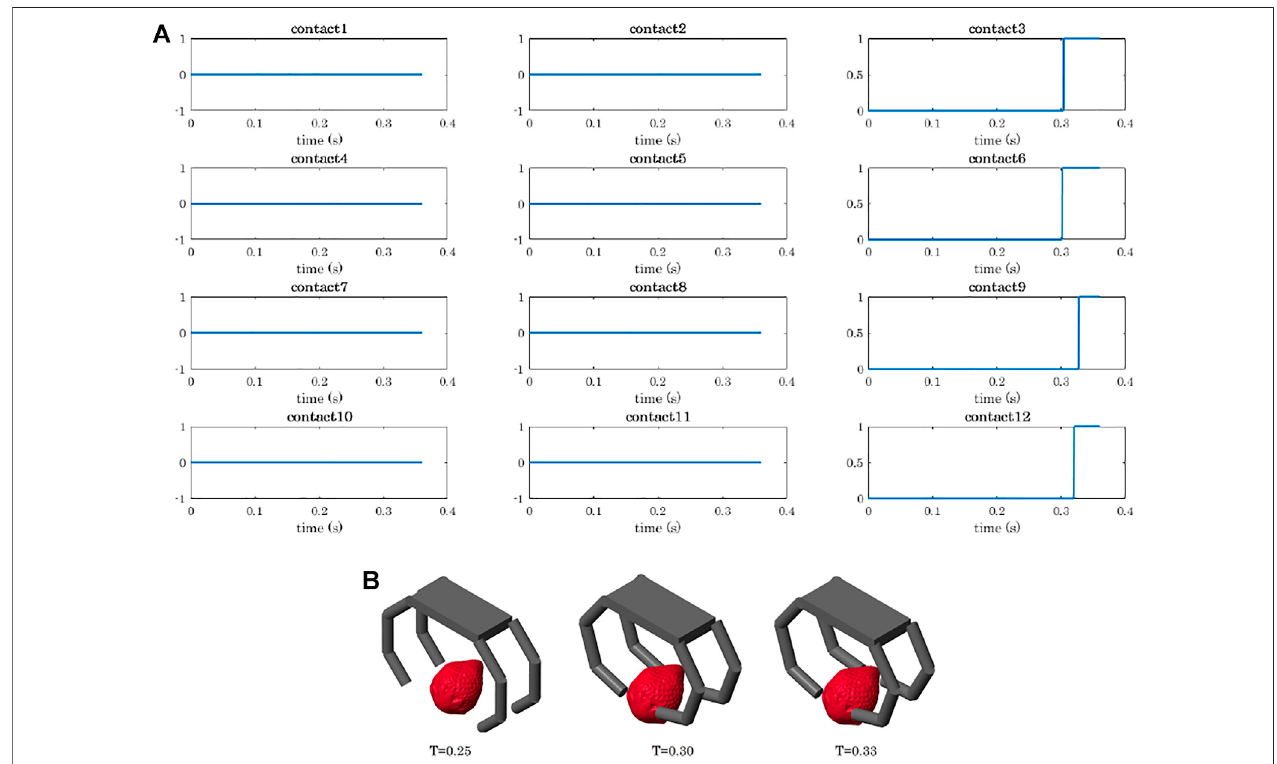
FIGURE 7 | Contact detection during the precision grasp of a strawberry. (A) Contact signals ordered as the phalanges of the hand: the rows correspond to the fi ngers (from 1 to 4), and the columns to the phalanges (from 1 to 3). When the signal is equal to 0, it means that no contact has been detected on the